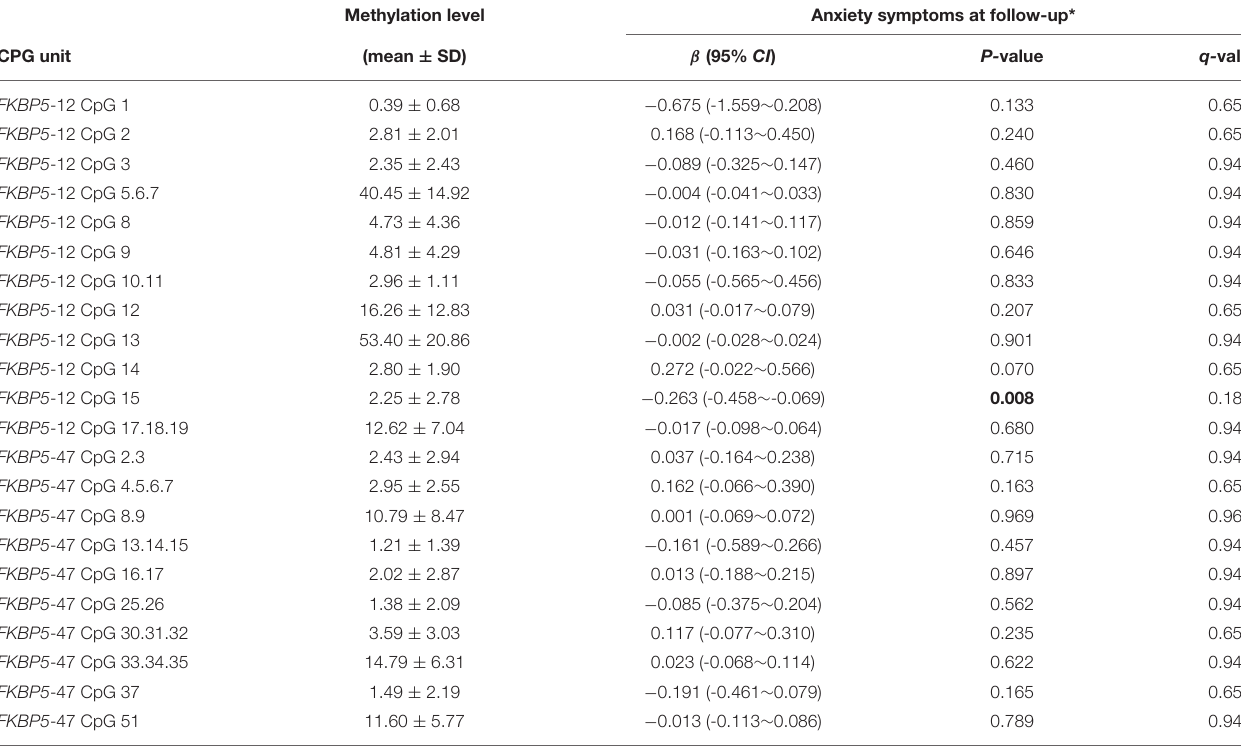
FKBP5-12andFKBP5-47representDNAfragmentpositioncorrespondingtoprimer#12and#47,respectively;TheGADscoresofanxietysymptomatfollow-upwereincorporatedinto thelinearregressionmodelasadependentvariable. *